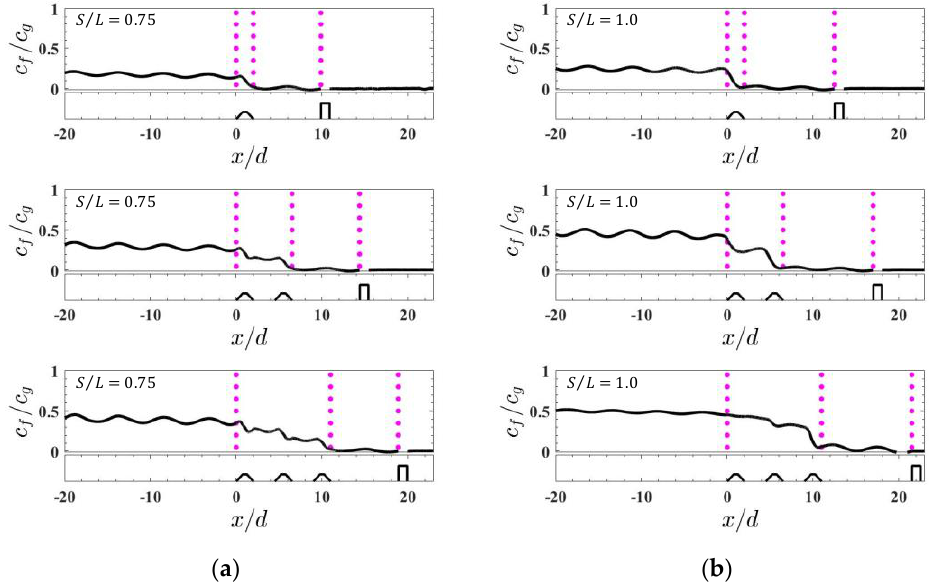
Figure 8. The velocity of the energy transport at different resonator lengths. ( a ) S / L = 0.75. ( b ) S / L = 1.0.